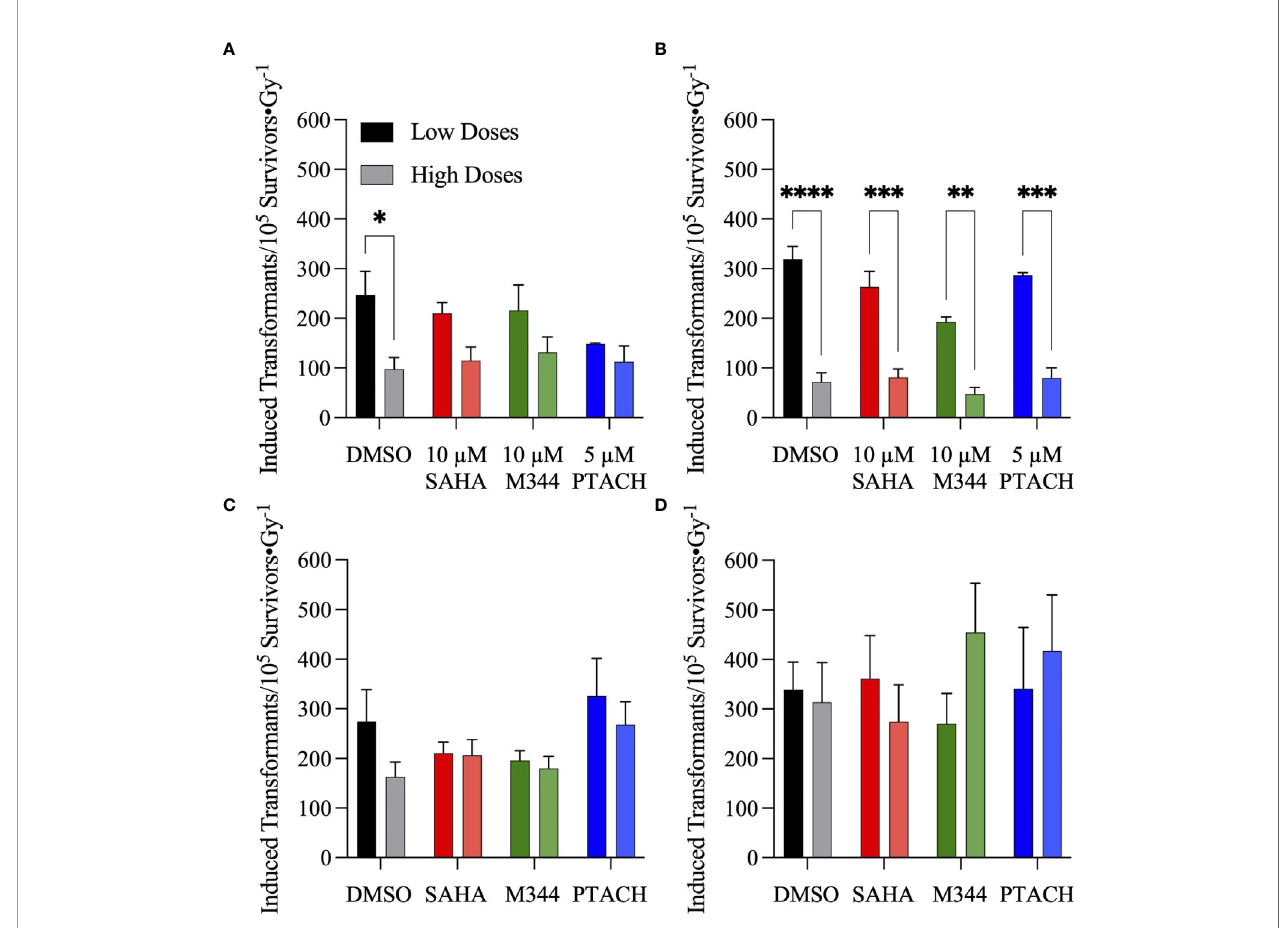
FIGURE 11 | Frequencies of normal NFF28 primary fi broblast anchorage-independent (A – I) colony formation in soft agar per unit dose ± SEM at low ( ≤ 25 cGy) and higher doses (>50 cGy) of cesium-137 g -rays (A) , 200 MeV protons (B) , 290 MeV/n C-12 ions (C) and 350 MeV/n O-16 ions (D) . IR-induced yieldsof transformants are background-corrected for levelsof transformants measured in DMSO and HDACi-treated/sham-irradiated cultures (~6.1 – 7.2).Low dose transformation frequencies are calculated from the slopeofinduction from 5 to 25 cGyand the higher dose transformation frequencies obtainedfrom the mean transformation frequencies at 1 Gy,the dose where peak (maximal) transformation occurs for both protons andC-12 ions. Both cesium-137 g -rays and protonsshow a pronounced hyper-radiosensitivity for NFF28 fi broblast invitro transformation at low doses. Asterisks mark signi fi cant differences at p -values of ≤ 0.05 (*), ≤ 0.01 (**), ≤ 0.001 (***),and ≤ 10 − 4 (****) bytwo-way